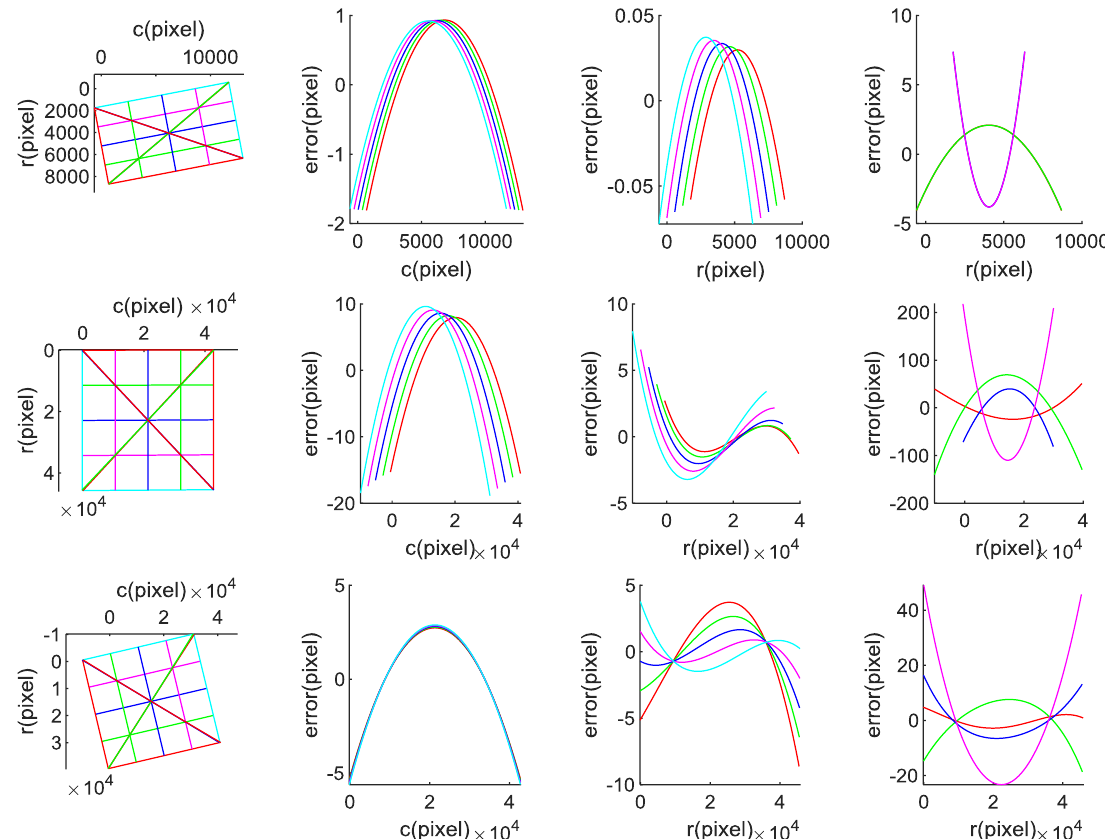
Figure 4. Projected trajectories and the fitting residual errors. The first column is the projection trajectories of the ground grid. The second column is the fitting residual errors of the projection trajectories projected form the cross-track horizontal lines. The third column is the fitting residual errors of the projection trajectories projected form the along-track horizontal lines. The fourth column is the fitting residual errors of the projection trajectories projected form the diagonal lines. The first row is the results of GF2-3, the second row is the results of JL1-2, and the third row is the results of WV3-19.